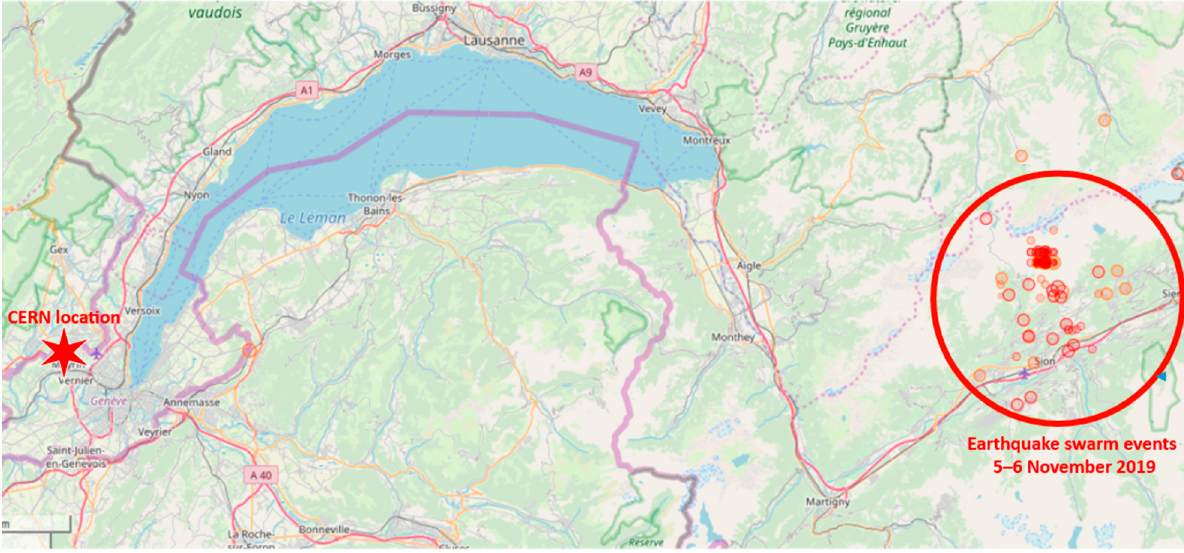
Figure 4. Earthquake swarm locations during maximal activity period of 5–6 November 2019 (R = 15 km).